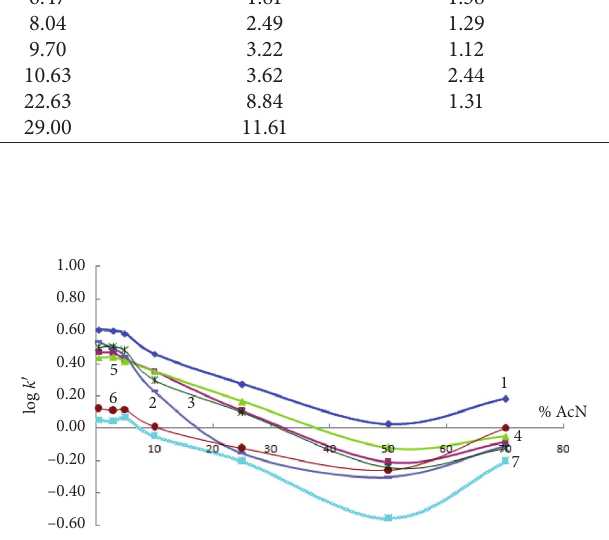
Figure 6: Effect of the acetonitrile content in the mobile phase on the PA retention on SP-2. Acids (100 μ g/ml): 1, caffeic; 2, sinapic; 3, salicylic; 4, ferulic; 5, p -coumaric; 6, gallic; 7, vanillic.